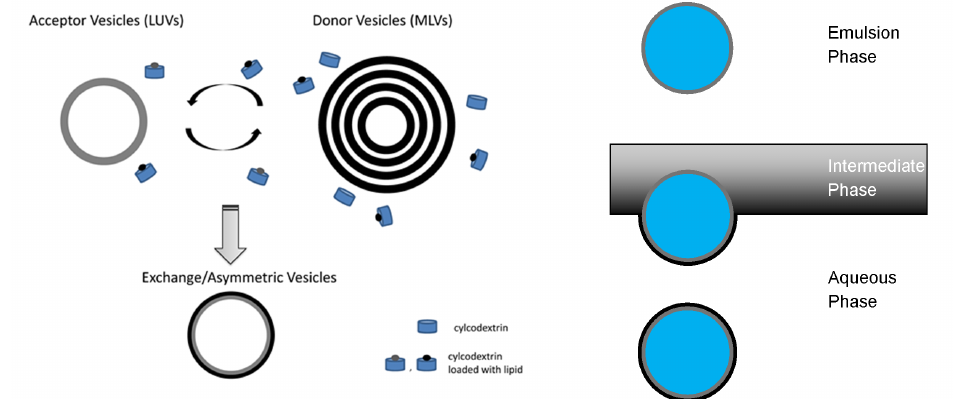
Figure 4. Schematic of asymmetric vesicle construction methods. The left is a schematic of cyclodextrin-mediated lipid exchange of the outer membrane leaflet [10]. The